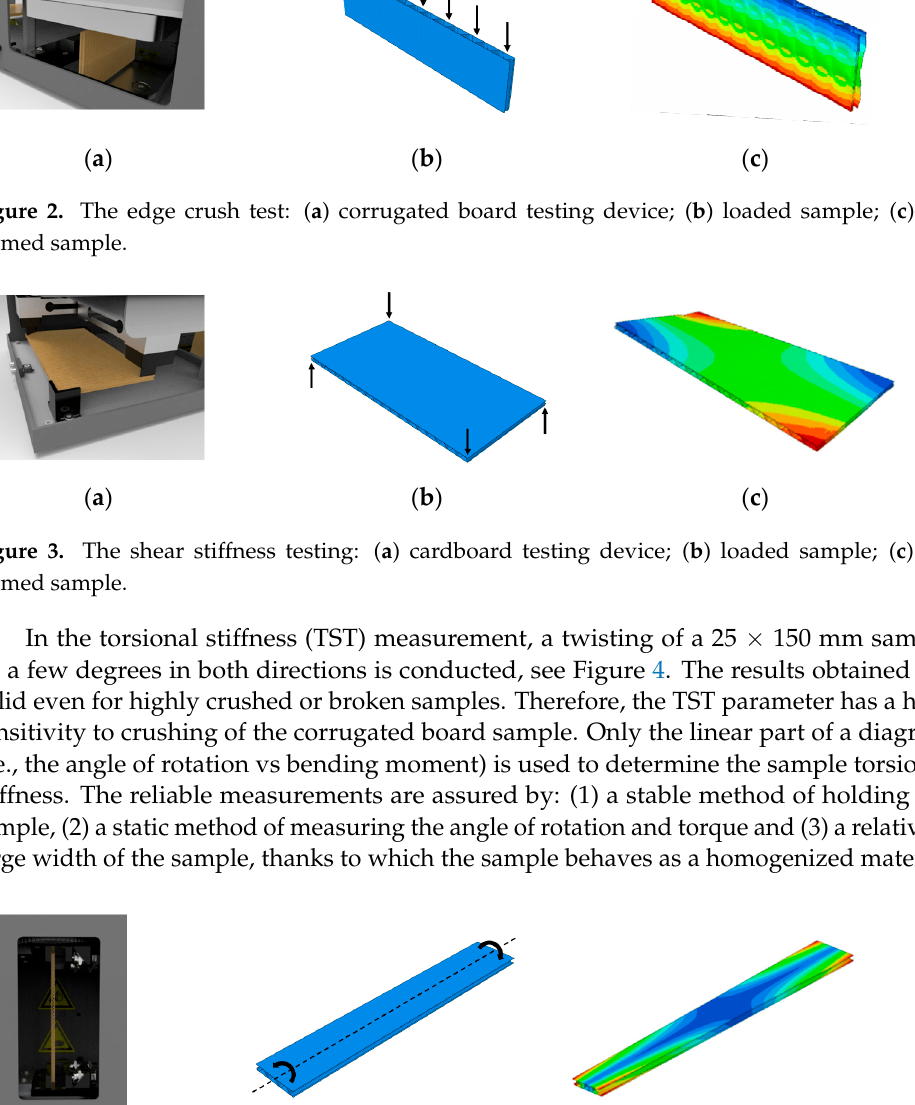
Figure 2. The edge crush test: ( a ) corrugated board testing device; ( b ) loaded sample; ( c ) deformed sample.